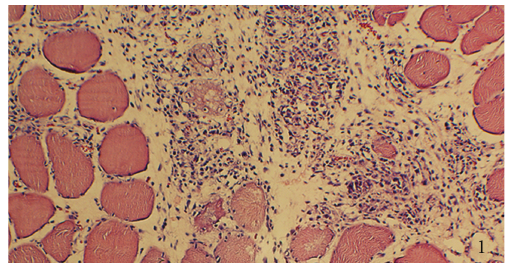
Figure 1: Soleus muscle of a specimen of the myositis group in a section stained with htx eosin. There is a marked inflammatory infiltrate (middle part): myofibers to the left and to the right.